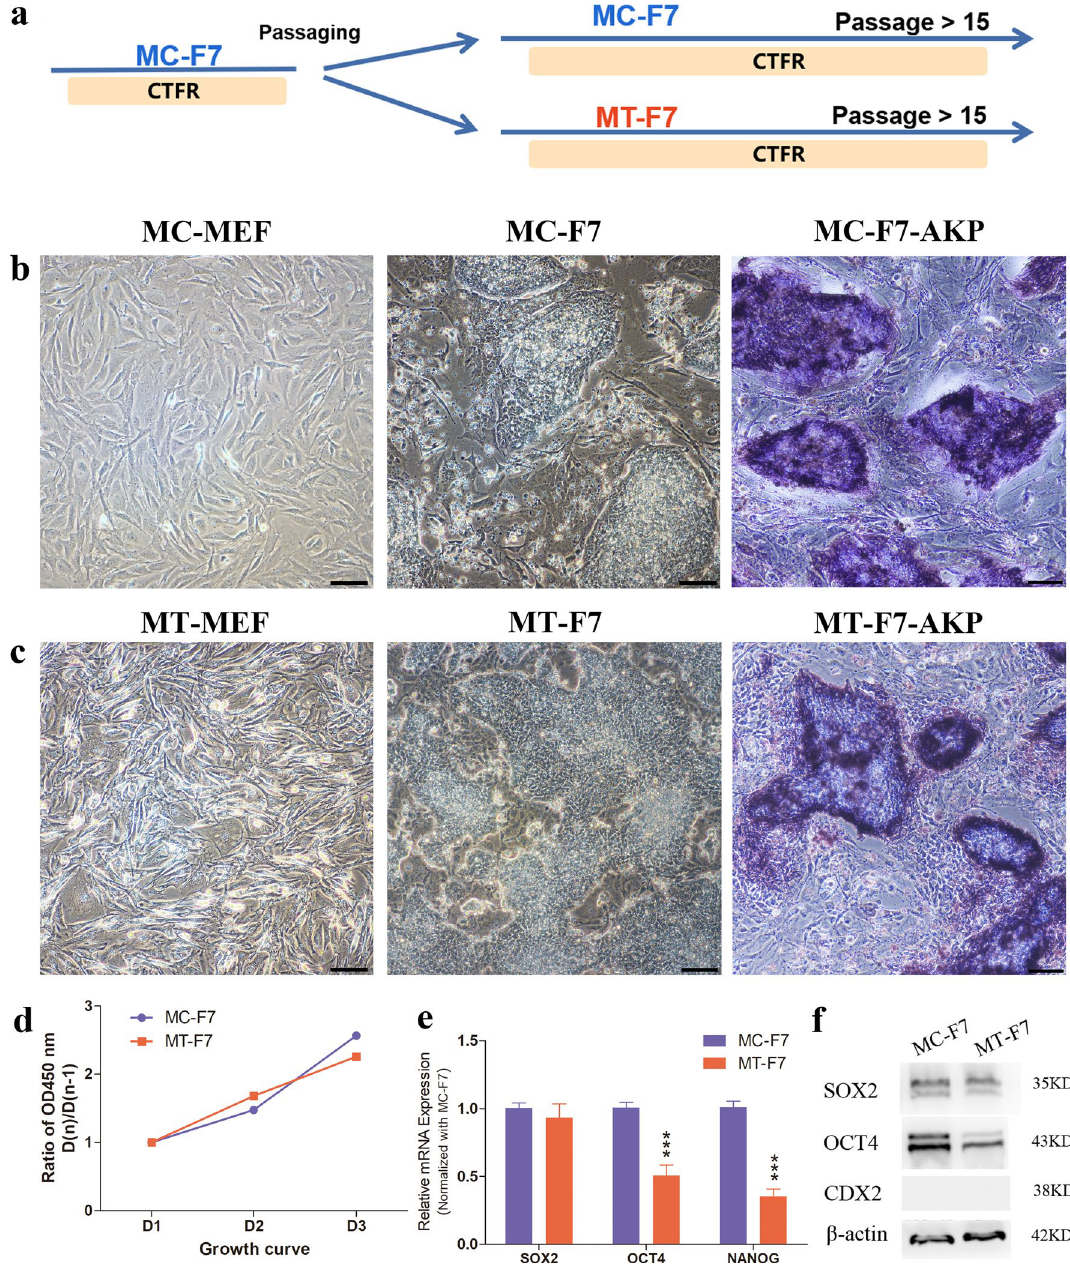
Figure 1. Characterization of bovine ESCs grown on mitomycin C treated and methanol fixed feeder cells. ( a ) Schematic diagram shows the experimental strategy for analyzing bESCs grown on mitomycin C-treated mouse embryonic fibroblasts (MC-MEFs) and methanol-treated MEFs (MT-MEFs). ( b ) The morphology and AKP staining of MC-MEFs and the F7 grown on MC-MEFs (MC-F7). Bar = 100 μm. ( c ) The morphology and AKP staining of MT-MEFs and F7 grown on MT-MEFs (MT-F7). Bar = 100 μm. ( d ) Growth curves of MC-F7 and MT-F7 cells. ( e ) Real-time quantitative polymerase chain reaction (RT-PCR) analysis shows the expression of the key pluripotency regulatory factors OCT4, SOX2, and NANOG in MC-F7 and MT-F7 cells. ( f ) Western blotting analysis shows the protein expression of OCT4, SOX2 and CDX2 in MC-F7 and MT-F7